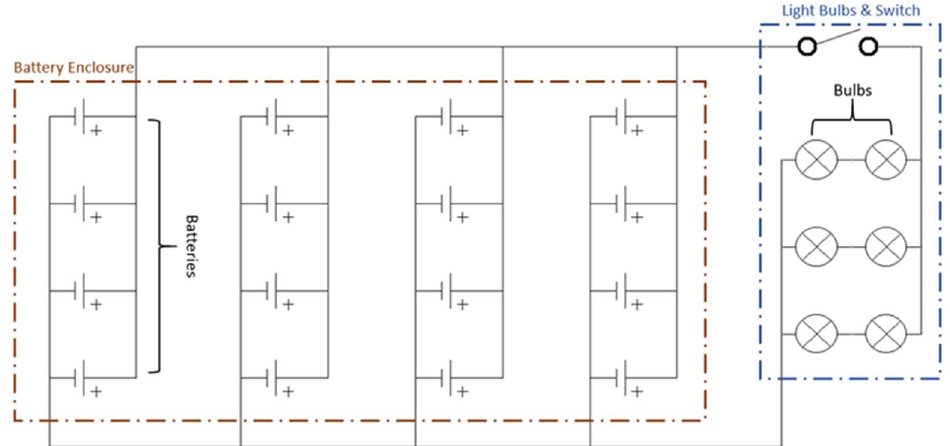
Figure 7. Wiring diagram for the batteries connected to a resistive load. Four parallel sets of four batteries are contained within the enclosure.